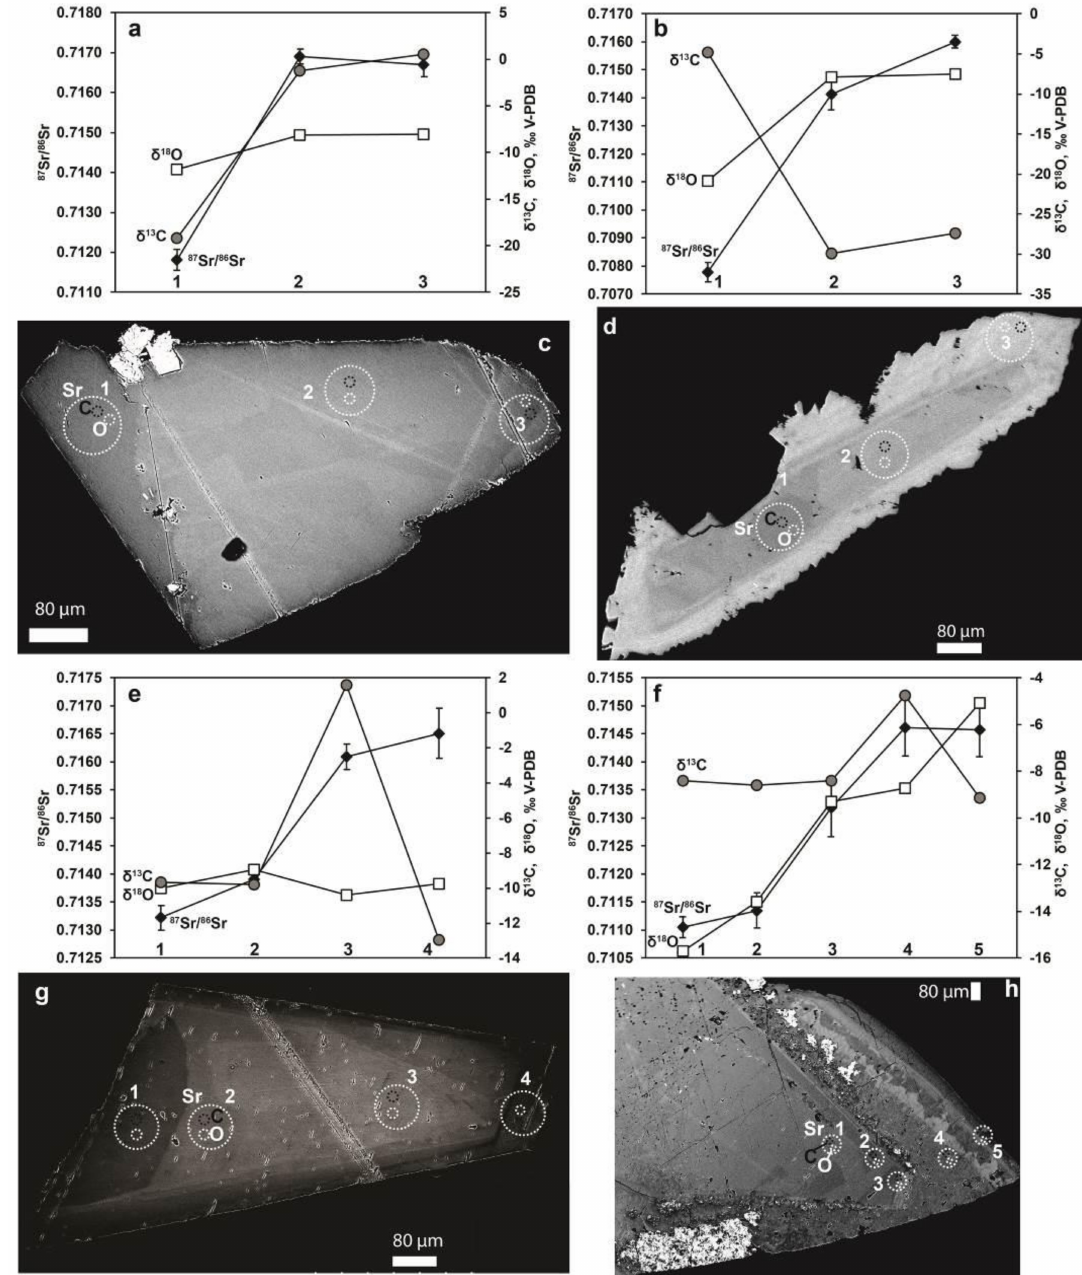
Figure 6. 87 Sr / 86 Sr values in transects of fracture coating calcite from Laxemar-Äspö ( a , b , e , f ) with spot locations (also for previously reported C and O isotope values [34,37,72]) marked on back-scattered SEM-images of polished crystal cross-sections, showing clear growth zonation (( c ) corresponds to ( a ), ( d ) to ( b ), ( g ) to ( e ), ( h ) to ( f )). ( a ) sample KLX09:192, ( b ) KLX09:740, ( c ) KLX10C:121, ( d ) KLX14A:80